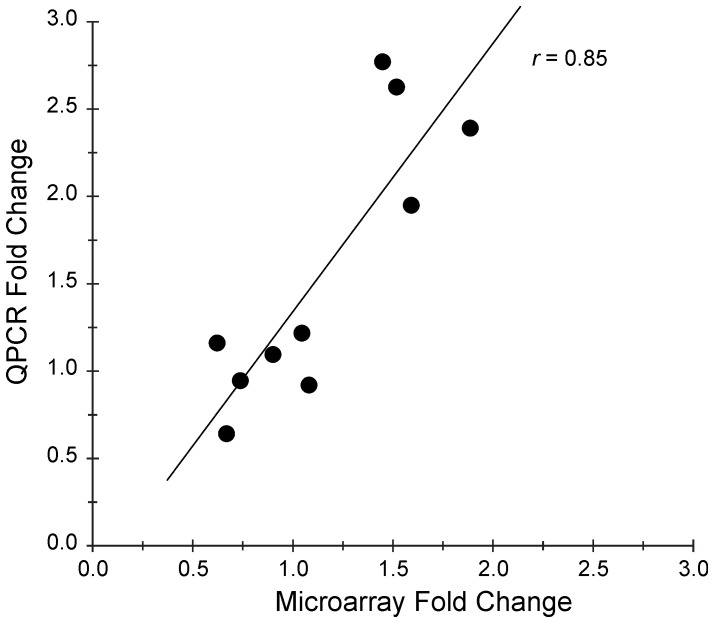
Relationship between Fold Change (FC) reported in microarray and QPCR experiments.Pearson’s correlation r = 0.86 and p<0.01. Circles represent individual genes. If more than one probe set was present in microarray dataset for a particular gene, an average FC was used for this gene as a “MAS5 FC”.